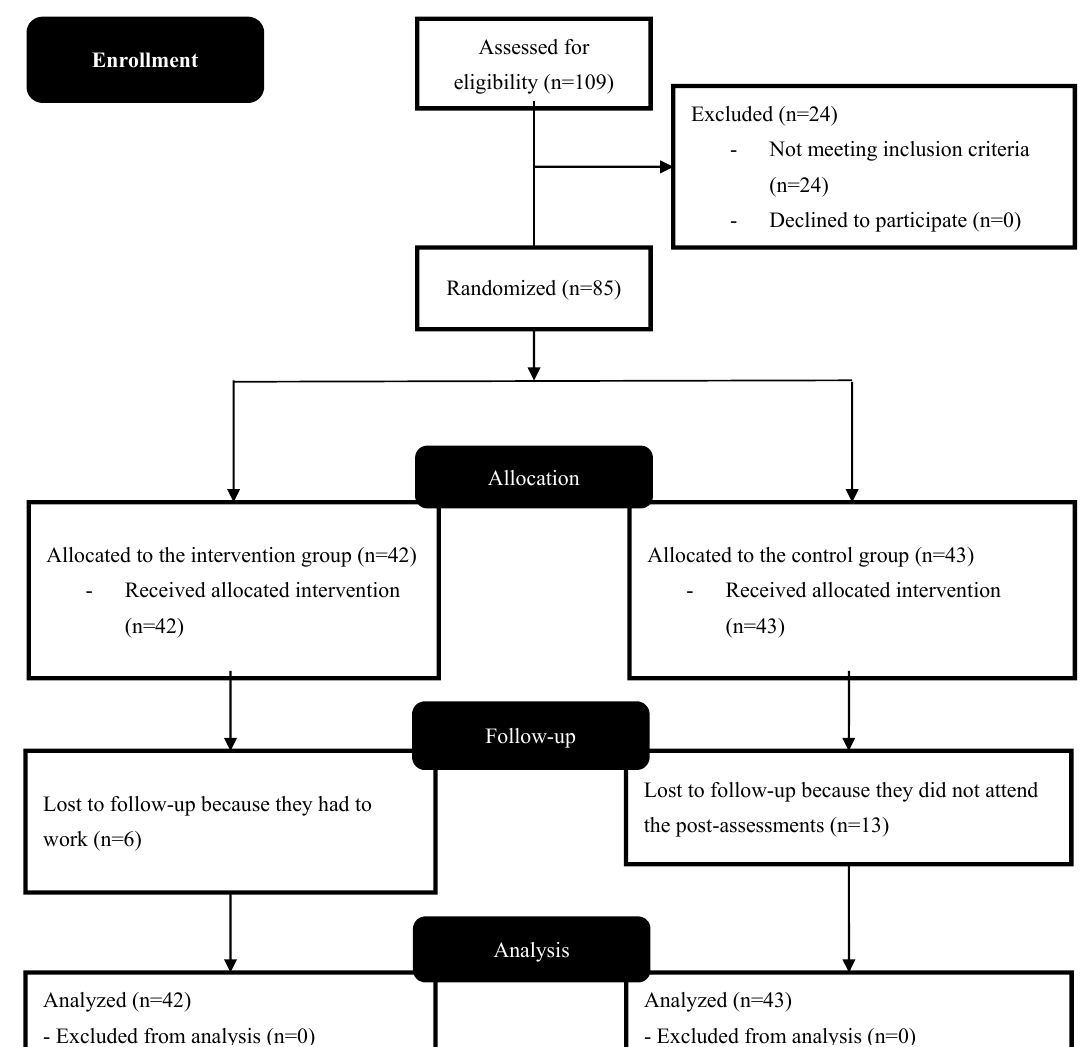
Figure 3. Flow diagram of the progress through the phases of the study.